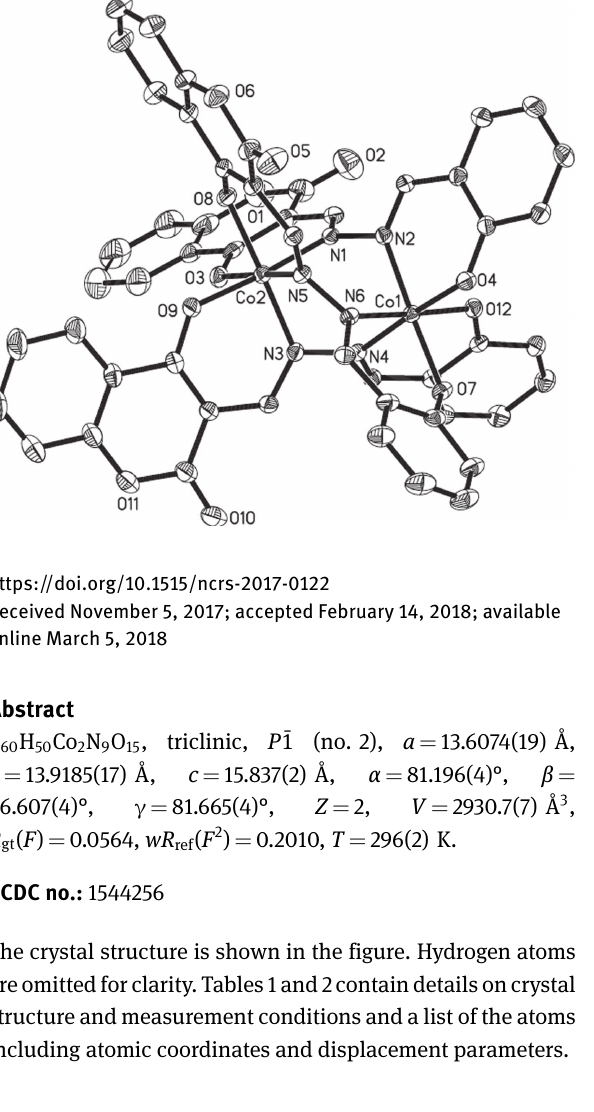
The crystal structure is shown in the figure. Hydrogen atoms are omitted for clarity. Tables 1 and 2 contain details on crystal structure and measurement conditions and a list of the atoms including atomic coordinates and displacement parameters.